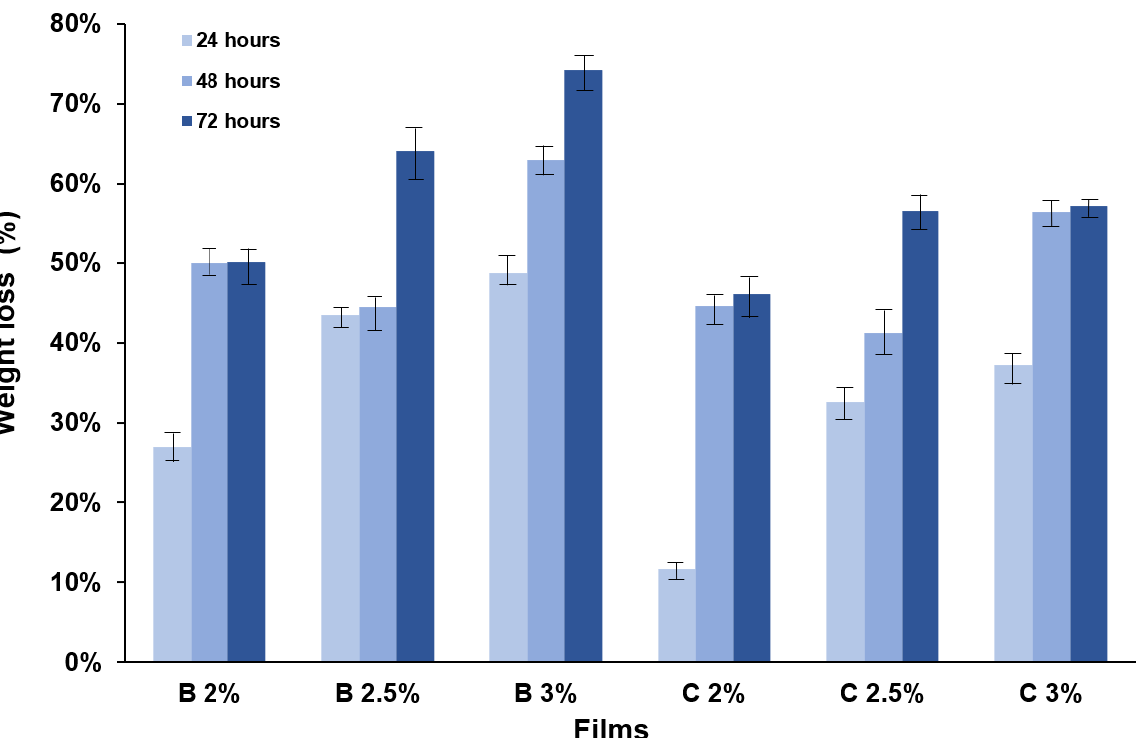
Figure 5. Percentage of weight loss (%WL) during enzymatic degradation on 24, 48, and 72 h of the composite and bilayer films. composite and bilayer